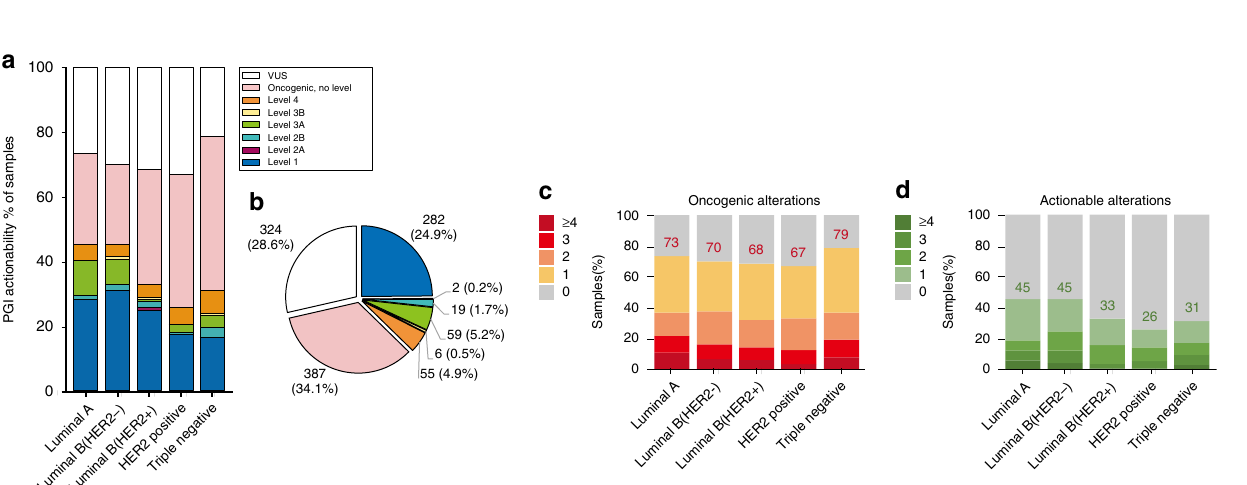
Fig. 4 Characteristics of mutations in oncogenic signaling pathways in prospectively sequenced Chinese breast cancer. a Landscape of pathway mutations in 1134 Chinese breast cancer samples classi fi ed by the molecular subtype and annotated with the variation type. The mutation counts in each sample and each pathway are provided above and on the right side, respectively. b Comparison of mutations in oncogenic signaling pathways in primary samples between our cohort and the MSKCC dataset. The middle circular spot corresponds to a value for odds ratio and the lines represent 95% con fi dence intervals. A red or blue horizontal line represents the signi fi cant or non-signi fi cant result of the comparison of mutation frequencies between our cohort and the MSKCC ’ s cohort in each signaling pathway, respectively. The red line indicates a higher mutation frequency in the corresponding pathway favors in the MSKCC ’ s cohort, while the blue line indicates a higher mutation frequency in the corresponding pathway favors in our cohort. A total of 1025 primary breast cancer samples from FUSCC are compared with 869 primary breast cancer samples from MSKCC by different mutation status in oncogenic signaling pathways using Fisher ’ s exact test, adjusted by false discovery rate (FDR). The asterisks indicate FDR < 0.05. c Signi fi cant enrichment of pathway mutations in different molecular subtypes of breast cancer. d Signi fi cant mutual exclusivity (blue) and co-occurrence (red) of gene mutations in pathways in Chinese breast cancer (all samples, right; luminal B/HER2 − , left). Spectrum bar: log10 (odds ratio (OR)); the color intensity represents the scale of the value. e Circus plot displaying the co-occurrent patterns among the oncogenic signaling pathways in our cohort. The line thickness corresponds to the number of mutations in two co-occurrent pathways. The signi fi cant co-occurrent patterns of mutations in the Hippo pathways are illustrated. Source data for b are provided as a source data fi le.